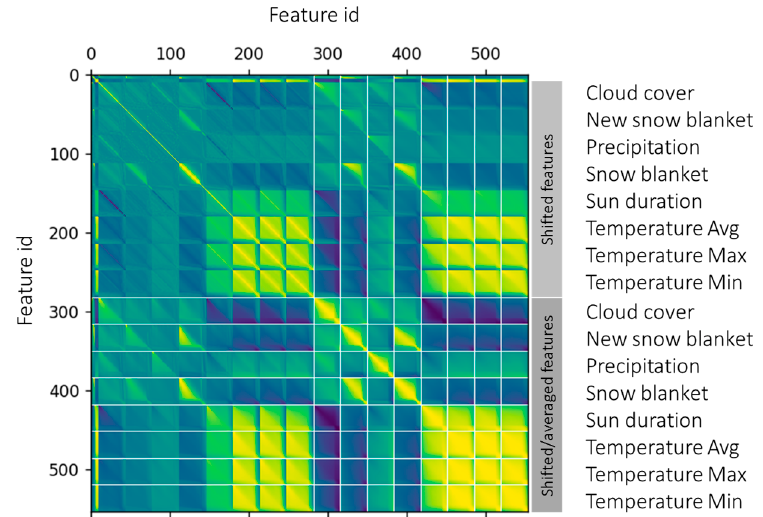
Figure 1. Figure represents correlation matrix of 544 original and generated attributes. Lighter color depicts positive correlation, darker color negative correlation. Each weather attribute has been transformed (with various shifts from 1 to 100 days) and then also with averages. Matrix is roughly divided on 2 × 2 fields, each field describing correlations between similar attributes (all 4 regions look similar). In each field we see a significant light block at the bottom right corner, which shows that sun duration and daily temperatures (average and extremes) are highly correlated to one another, even more so, when we take into account averaging over multiple